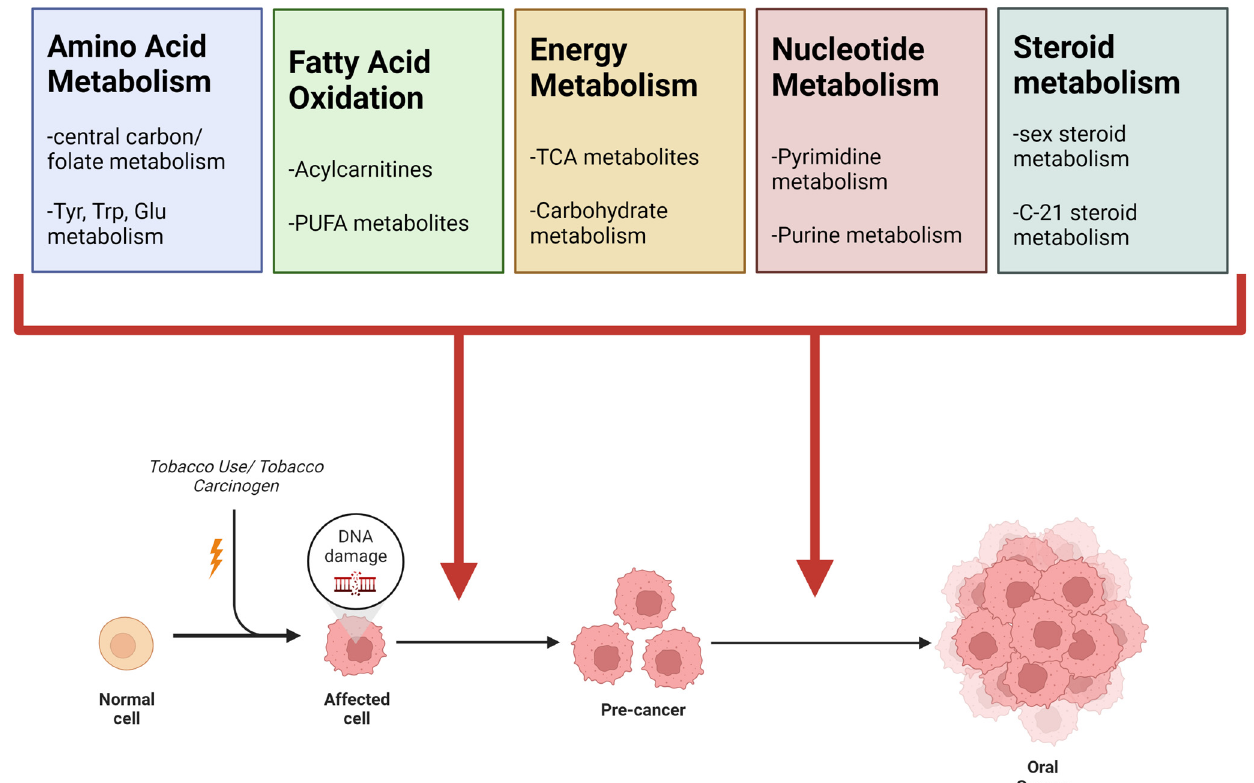
Figure 8. Summary of common metabolic alterations observed between tobacco use and oral cancer.